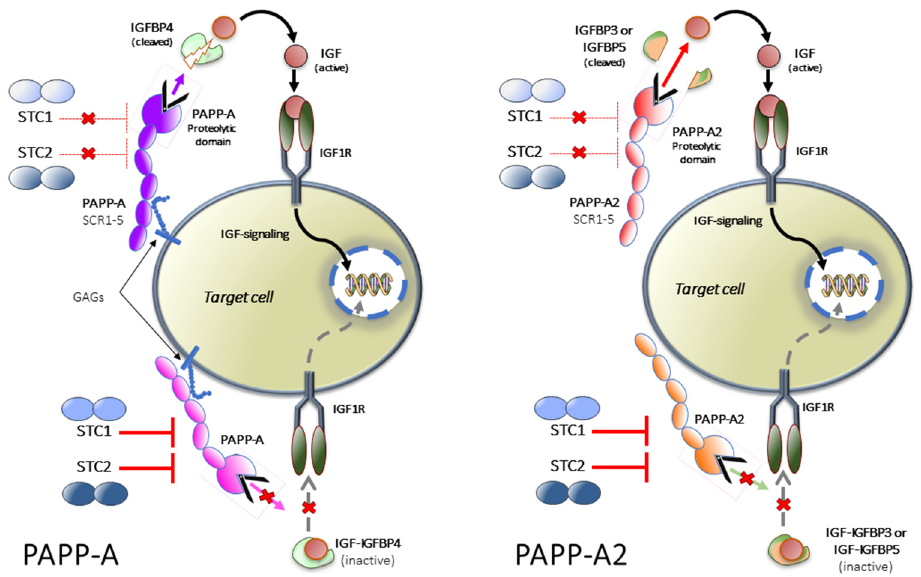
Figure 2. The role of PAPP-A, PAPP-A2, STC1 and STC2 in the IGF system. The insulin-like growth factors (IGFs) circulate bound to high-affinity IGF-binding proteins (IGFBPs). IGFBP4, bound to IGF, can be cleaved by the proteinase pregnancy (IGF1R). Stanniocalcin 2 (STC2) inhibits PAPP-A proteolytic activity through covalently